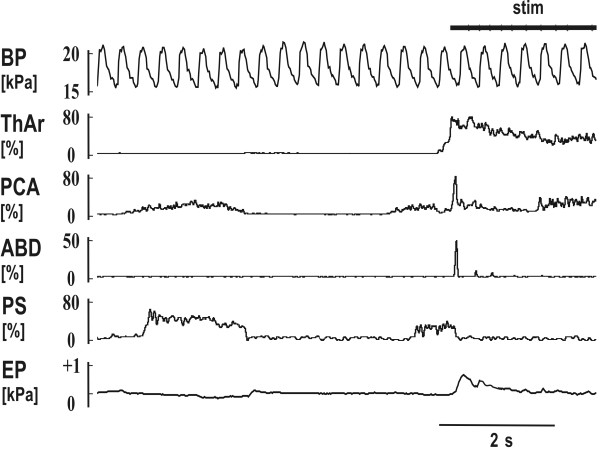
Mechanical stimulation of the trachea (stim) with short reflex expiration (ERt) during the inspiratory period of breathing. The stimulation immediately terminated an inspiration (rapid suppression of PCA and PS) and induced the ERt (abrupt activation of ThAr, PCA and ABD). Two much weaker ERt were detectable in the record of ABD, before the initial cough inspiration began (activation of PCA at the end of the record). See Fig. 1 for abbreviations.